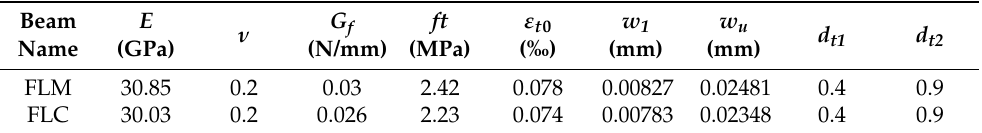
Table 2. Input parameters of the examined RCbeams.